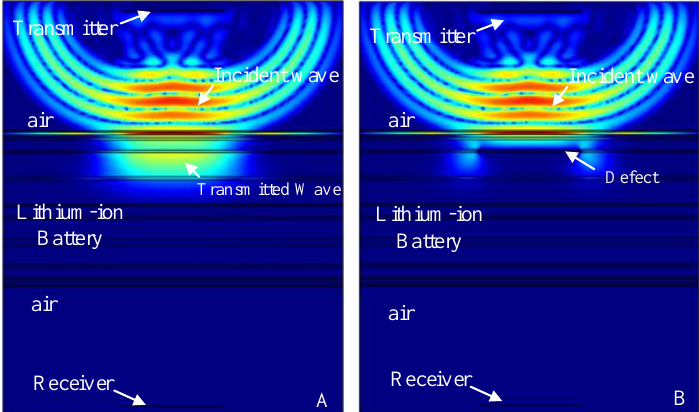
Figure 13. Finite element simulation of time snapshots of the propagation of the ultrasonic wave in the lithium- ion battery (11.520 μs). ( A ) The simulation result without a defect; ( B ) the simulation result with a stomata defect in the second electrolyte layer.